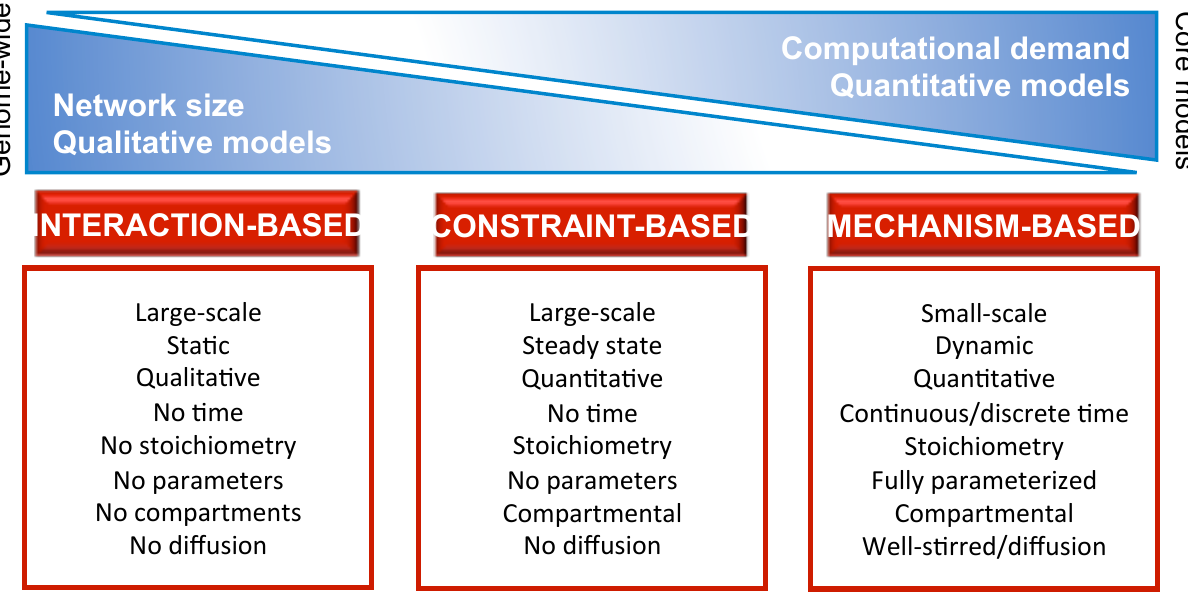
Figure 1. Schematic overview of the main modeling approaches for biological systems, together with their principal characteristics and differences. Moving from the coarse-grained ( interaction-based , constraint-based ) to the fine-grained ( mechanism-based ) approach, models vary with respect to: (i) the size of the system, defined in terms of the number of components and respective interactions included in the model, which decrease from genome-wide to core models (Section 2.1); (ii) the computational costs required for the analysis of the model, which increase from the analysis of the topological properties of the network typical of interaction-based models (Section 3.1), to the study of flux distributions typical of constraint-based models (Section 3.2), to the investigation of the system dynamics typical of mechanism-based models (Section 3.3); (iii) the nature of the computational results together with the predictive capability, which changes from qualitative to quantitative while moving from interaction-based models (characterized by a high level of abstraction) to mechanism-based models (fully parameterized and describing the system at the level of the functional chemical